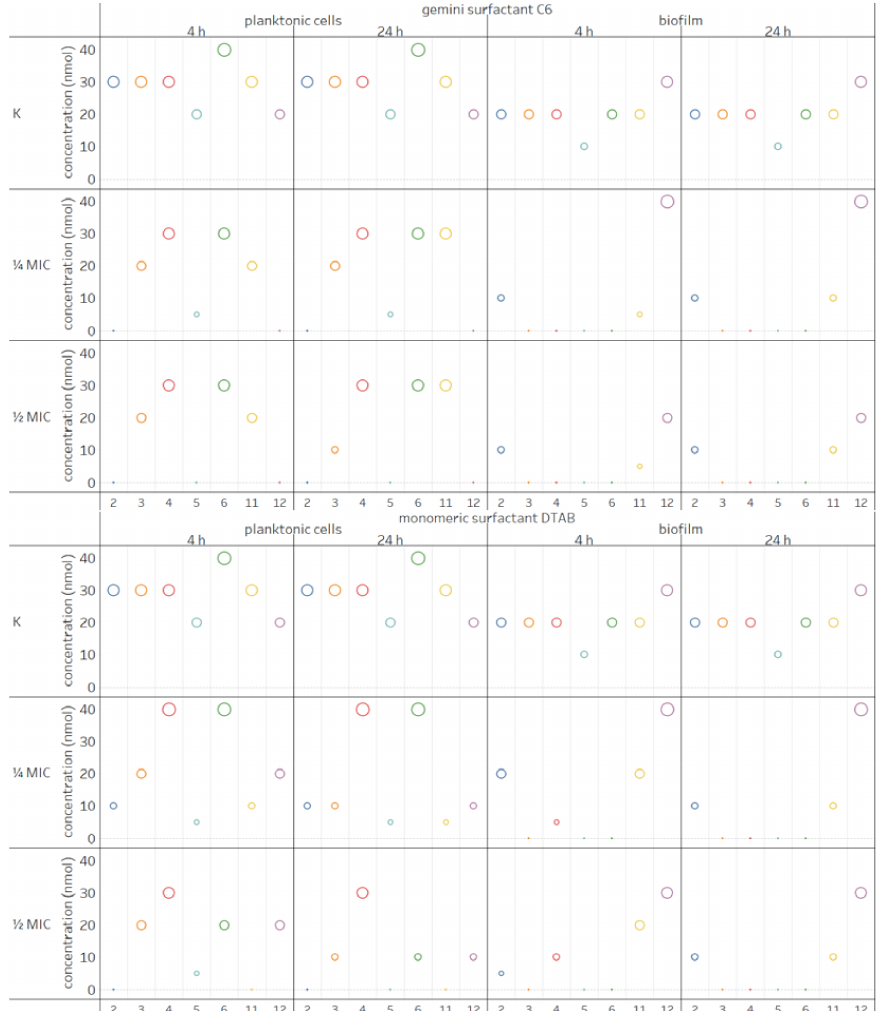
Figure 3. Effect of gemini C6 and monomeric DTAB surfactants at 1 ⁄ 4 and 1 ⁄ 2 MIC concentration on enzymatic profile of P. aeruginosa in biofilm and planktonic cells (the numbers 2–12 plotted on the horizontal axis refer to the enzyme number in the API ZYM test: 2—alkaline phosphatase, 3—esterase (C4), 4—esterase lipase (C8), 5—lipase (C14), 6—leucine arylamidase, 11—acid phosphatase and 12—napthol-AS-BI-phosphohydrolase,